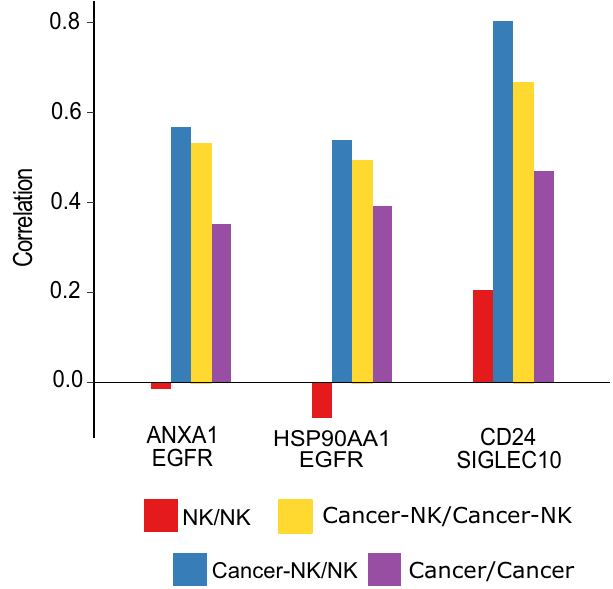
Fig. 4 Inference of protein-protein associations by gene expression pro fi ling. Barplots showing increased correlation values among CIDs for three gene pairs ANXA1/EGFR , HSP90AA1/EGFR , and CD24/SIGLEC10 . NK = Natural Killer Cells. Legend key indicates cell status at the beginning and the end of the time-course